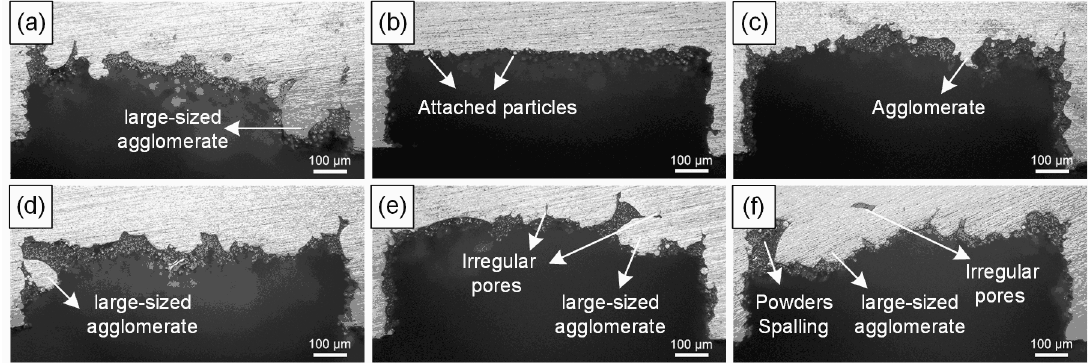
Figure 9. Section of overhanging structure parts of lower surface: ( a ) 1-I; ( b ) 8-I; ( c ) 10-I; ( d ) 1-II; ( e ) 8-II; ( f ) 10-II.